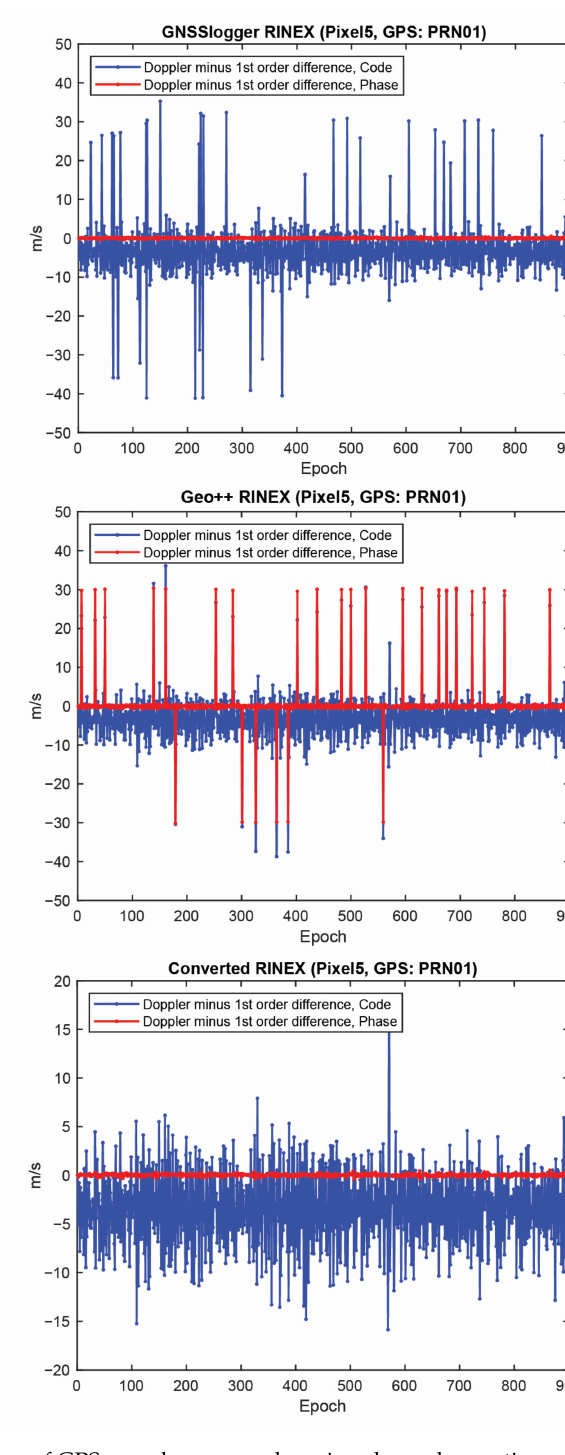
Figure 8. First-order differentiation of GPS pseudorange and carrier-phase observations as well as Doppler observations on L1 frequency for PRN 01 (Google Pixel